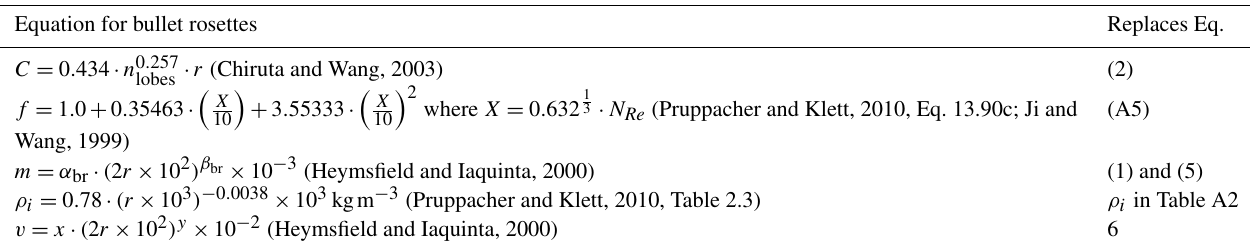
Table A5. Equations used in the sublimation calculations for bullet rosettes. The other equations used are the same as for a sphere and are given in the text. Equation for bullet rosettes Replaces